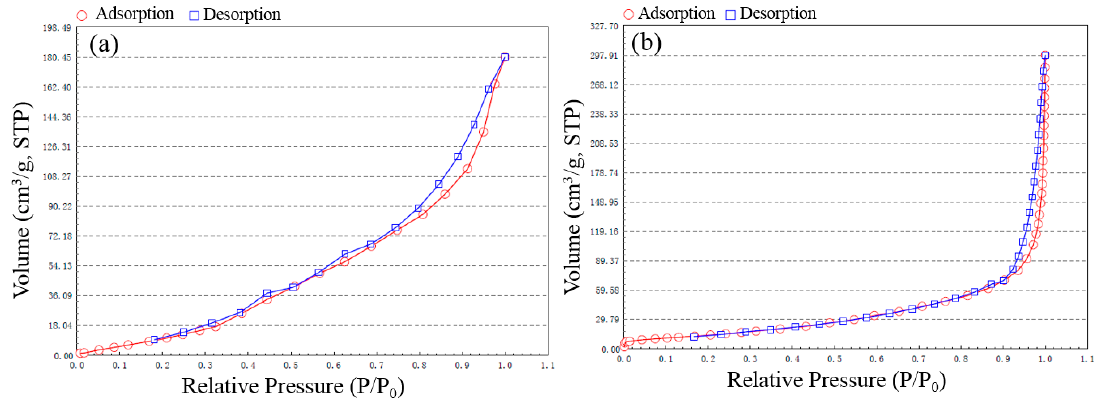
Figure 10. CO 2 adsorption-desorption curves of ( a ) Gd-doped TiO 2 nanotube arrays and ( b )titanium dioxide (P–25)